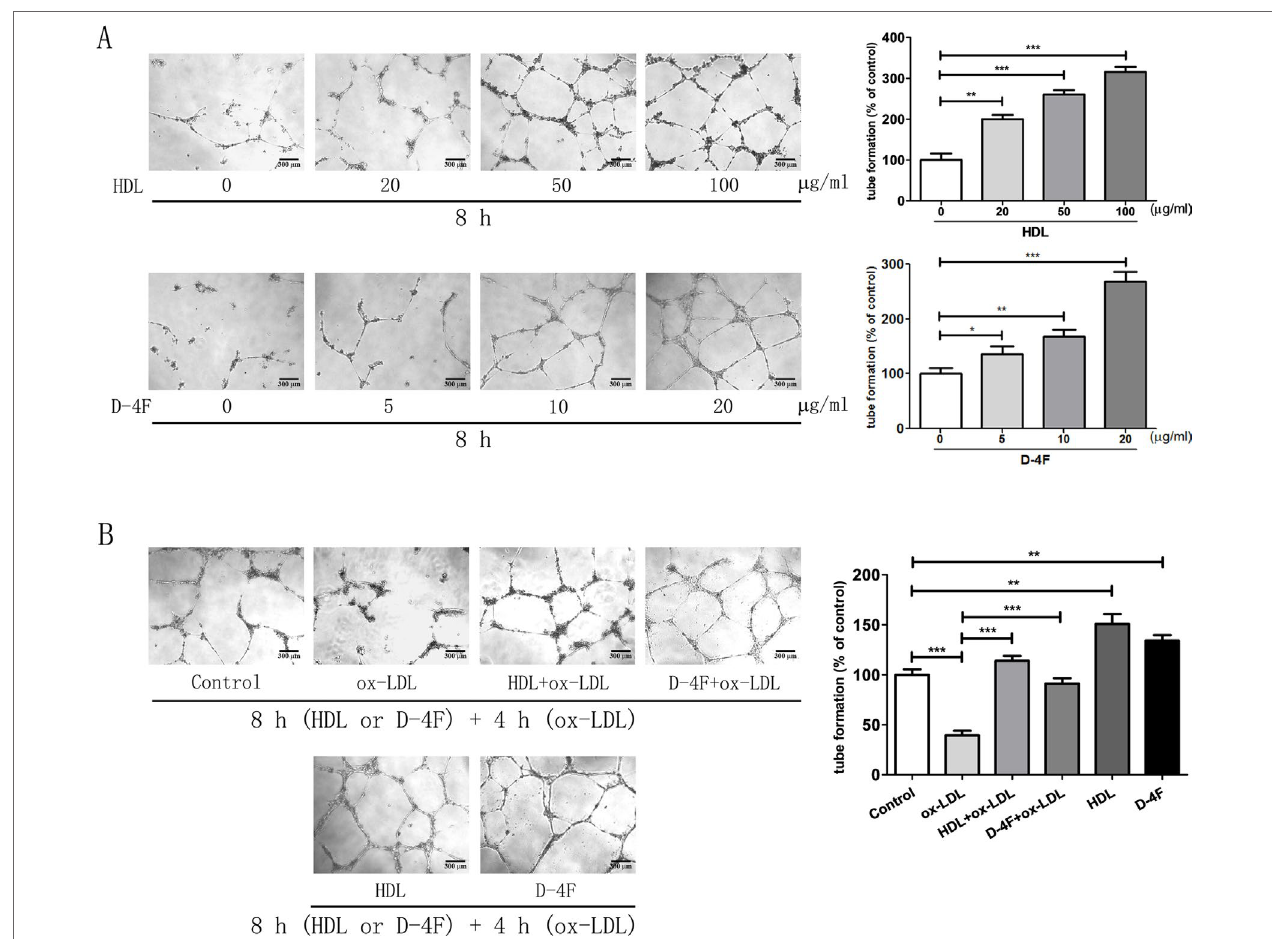
FIGURE 2 | HDL and D-4F improved the tube formation of endothelial cells challenged by ox-LDL. (A) Endothelial cells were incubated with various doses of either HDL or D-4F for 8 h. (B) Alternatively, endothelial cells were pre-incubated with either HDL (100 μg/ml) or D-4F (20 μg/ml) for 8 h, and further treated with ox-LDL (100 μg/ml) for 4 h. Tube formation was recorded in Matrigel with a light microscopy (100×). The bar length was 300 µm. * p < 0.05; ** p < 0.01; *** p <